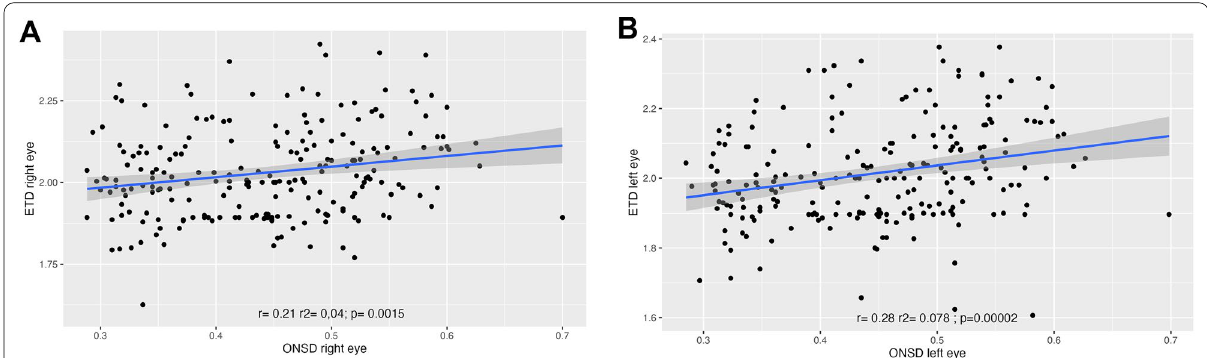
Fig. 3 A : Optic nerve sheath diameter (ONSD) and ETD relation in right eye. 3 B : Optic nerve sheath diameter (ONSD) and ETD relation in left eye